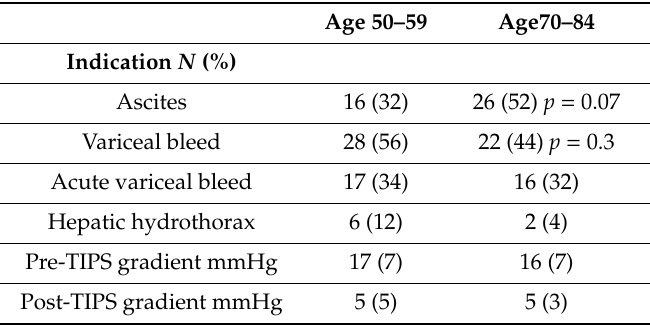
Table 2. TIPS data in the study groups.